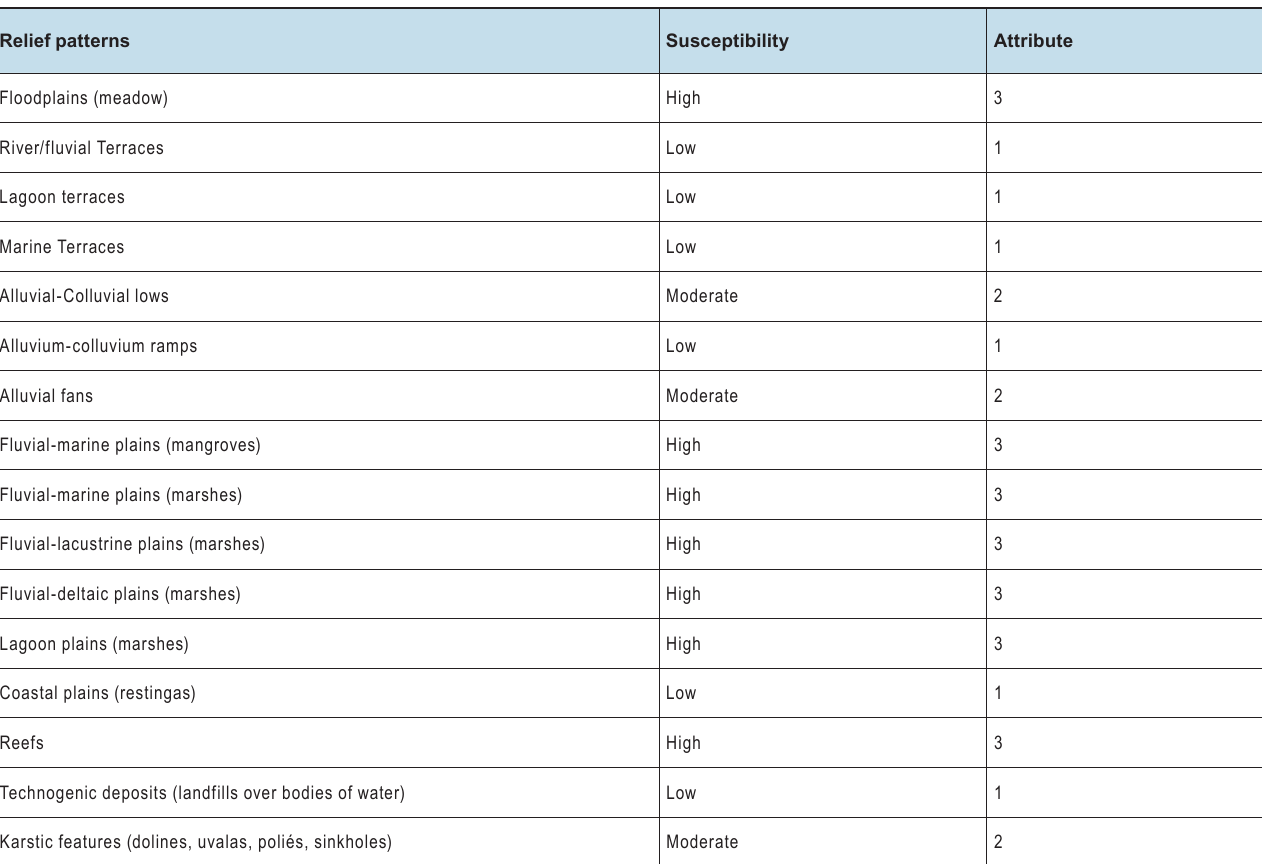
table 1 - Flood susceptibility classes of the Relief patterns adapted from Dantas (2013).